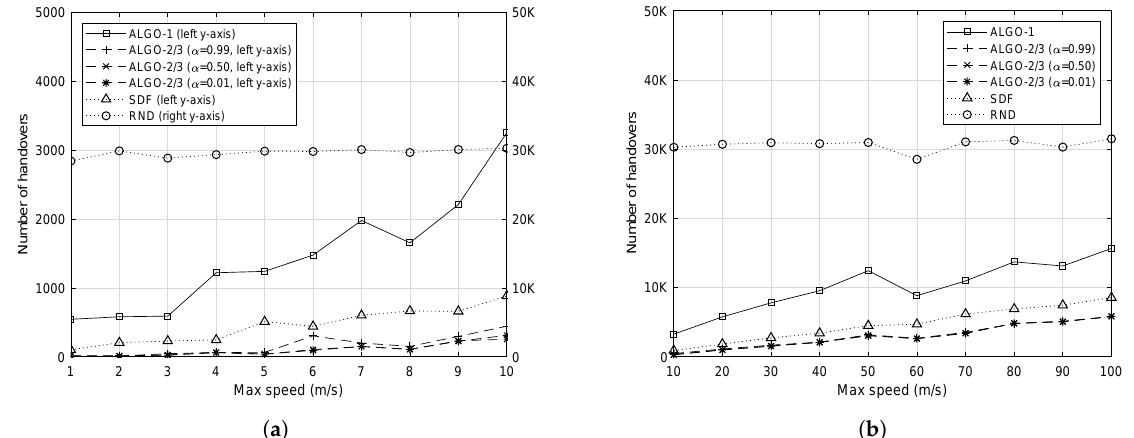
Figure 7. Total number of handovers with respect to different upper bounds on the speed of 50 mobile IoT devices. ( a ) When IoT devices are moving at a slow speed; ( b ) When IoT devices are moving at a fast